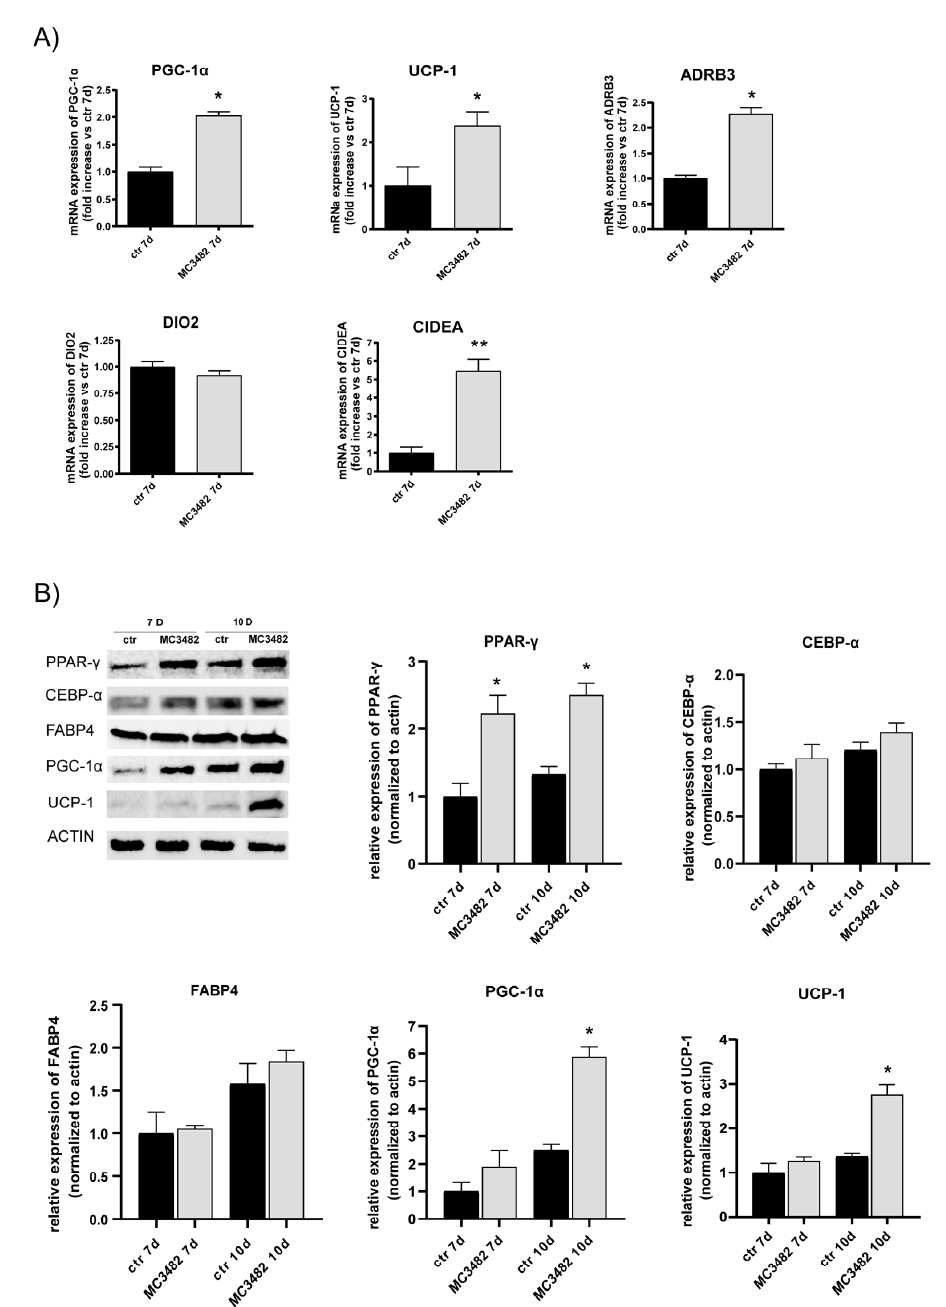
Figure 2. Effects of SIRT5 blockade on adipocyte differentiation. ( A ) PGC-1 α , UCP-1, ADRB3, DIO2 and CIDEA mRNA expression levels were evaluated at day 7 of differentiation by RT-qPCR in primary preadipocytes derived from iWAT and induced to differentiate with or without MC3482. ( B ) Western blot analysis of adipogenic marker expression in 3T3-L1 cells induced to differentiate with or without MC3482. Western blot analysis was performed by ImageQuant software. Values are expressed as means ± SEM of three independent experiments. * p < 0.05, ** p < 0.01 vs. untreated control (ctr) at corresponding time points.